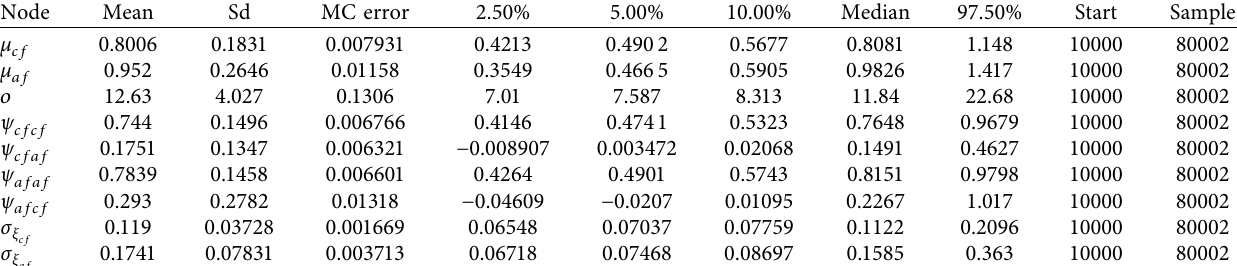
Table 2: The simulation results of posterior parameters of WTI and INE future.